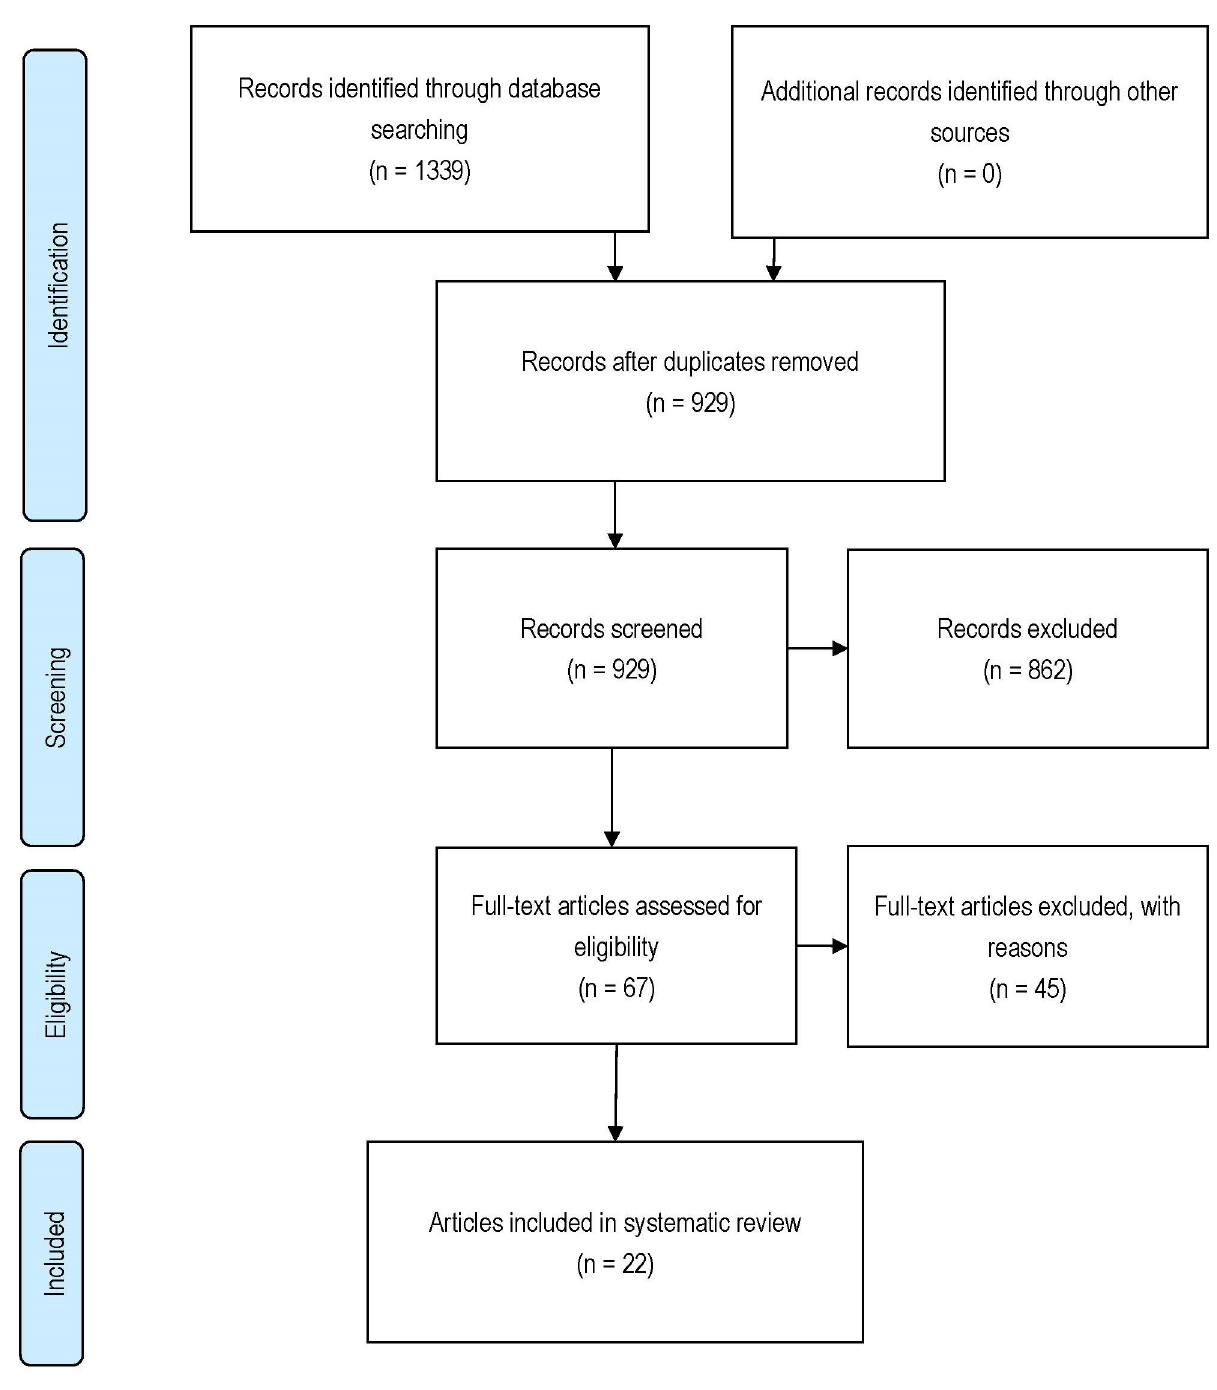
Figure 2. Study identification, screening, eligibility, and selection process.